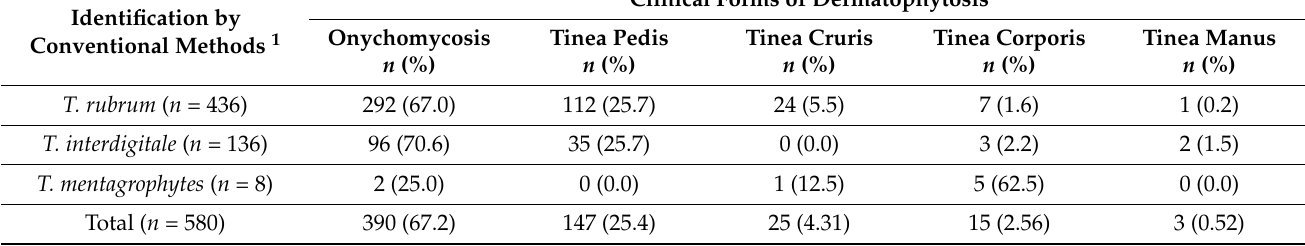
Table 1. Frequency and distribution of 580 Trichophyton isolates from seven laboratories initially identified according to isolate morphology and clinical localization of lesions.